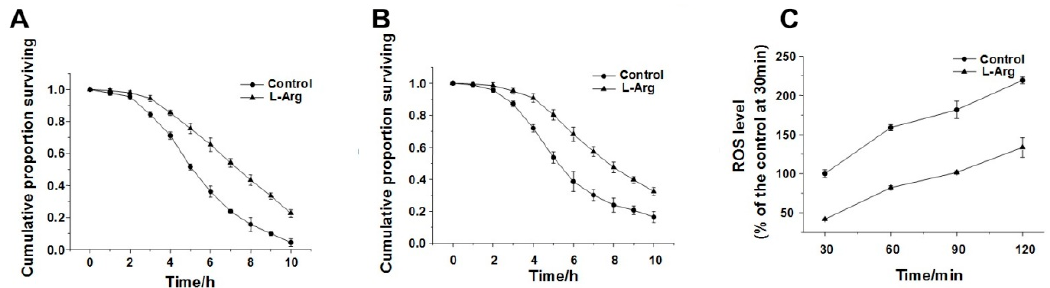
Figure 1. L -Arg enhances the resistance of C. elegans to stress conditions. ( A ) Protective effects of L -Arg (1 mM) on N2 wild-type C. elegans under oxidative stress; ( B ) Protective effects of L -Arg (1 mM) on N2 wild-type C. elegans under heat stress; ( C ) L -Arg at a concentration of 1 mM decreased ROS accumulation in C. elegans in response to juglone-induced oxidative stress, over time. All experiments were conducted in triplicate and were conducted in a double-blind manner.